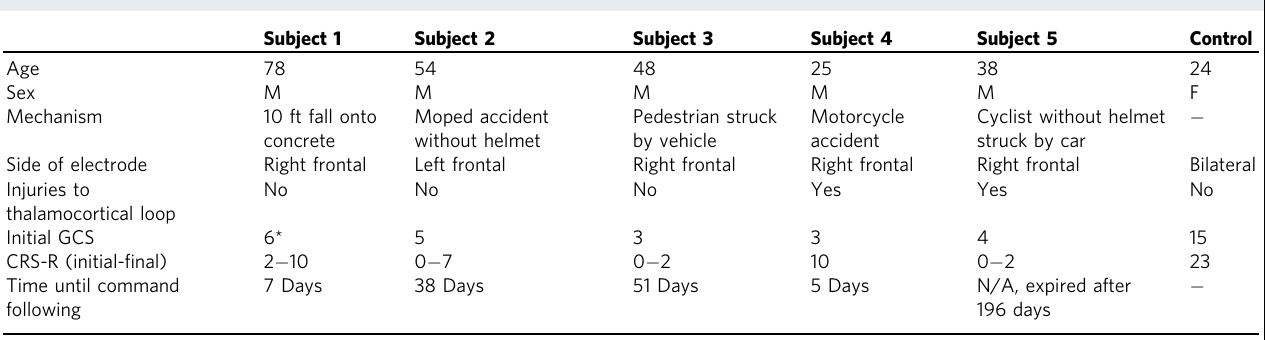
Fig. 1 for a detailed timeline of injury, implantation, and mea- sures of